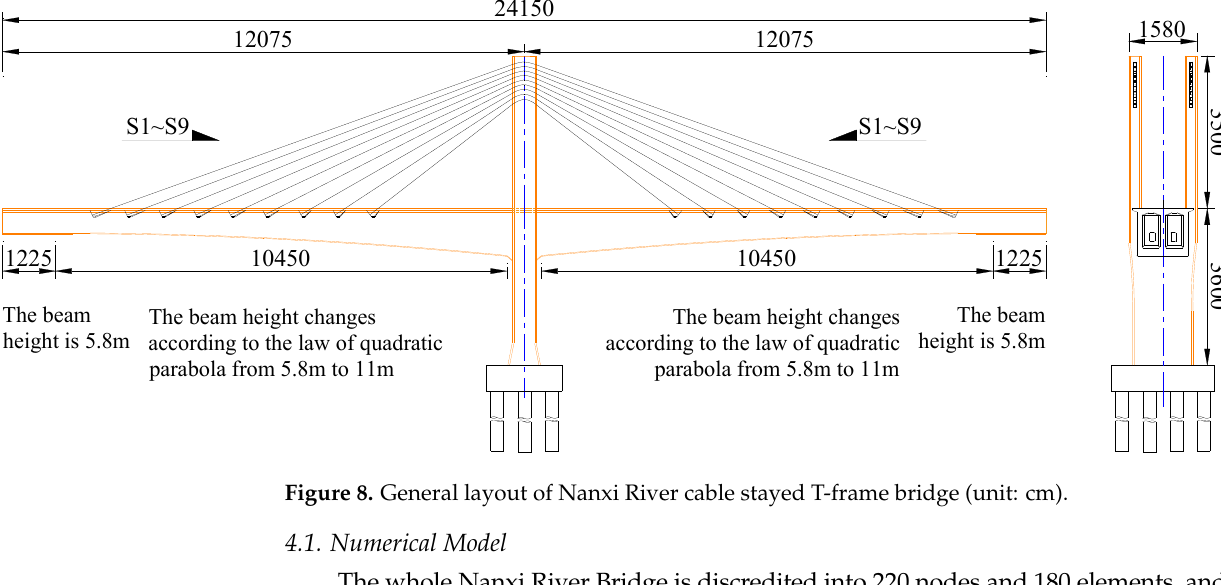
Table 1. Properties of the structural members.